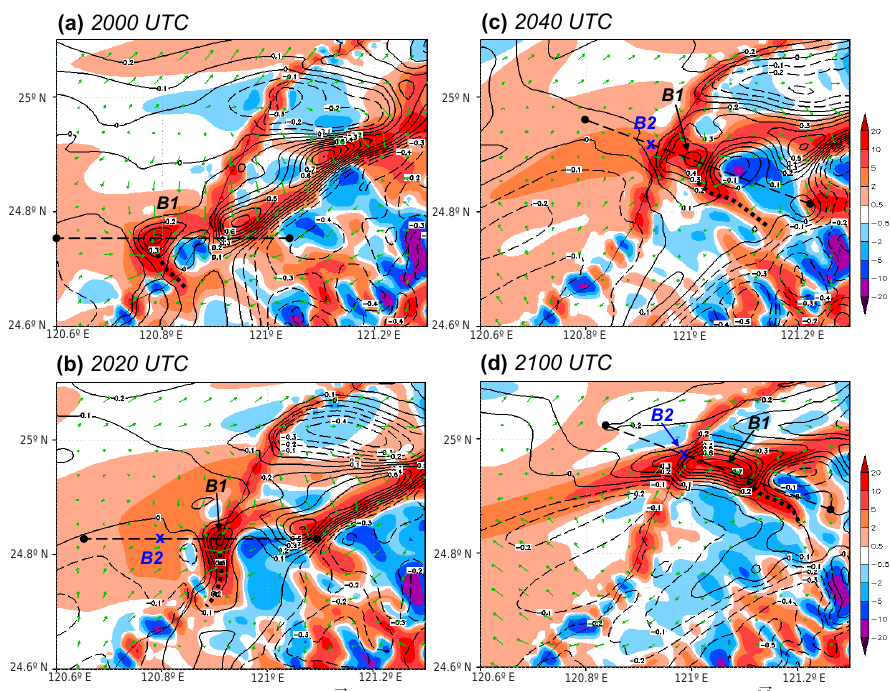
Figure 12. CReSS simulation of convergence/divergence (10 − 4 s − 1 , shading, scale to the right, positive for convergence), 10m wind per- turbation (ms − 1 , green vectors, reference length at bottom), and potential temperature perturbation ( θ (cid:48) , K, contours every 0.1K, dashed for negative values) at the surface every 20min from (a) 20:00UTC to (f) 21:00UTC, 11 June 2012. Cells B1 (black) and B2 (blue), axis of convergence (thick dotted line) produced by downdraft outflow of B1, and locations of vertical cross sections as in Fig. 10 (straight dashed lines) are